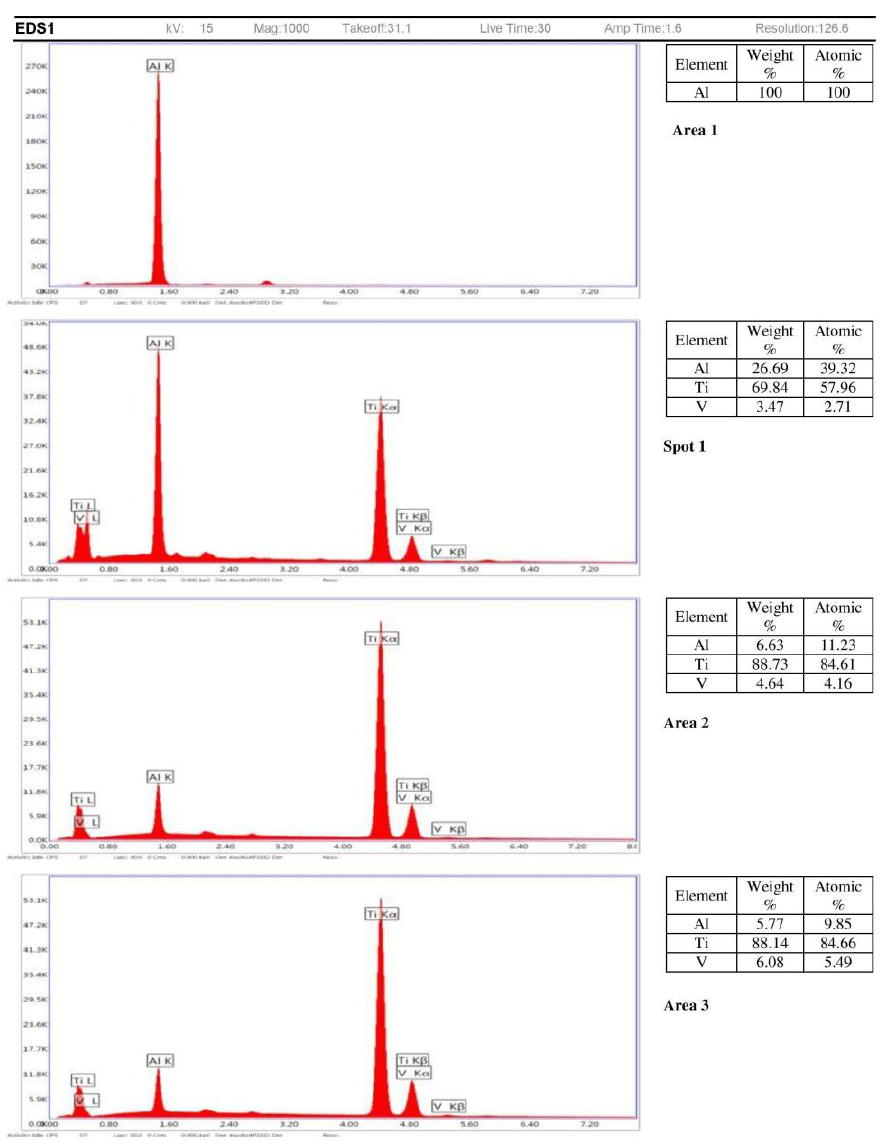
Figure 11. EDS analysis graphs of selected areas of Sample A3.